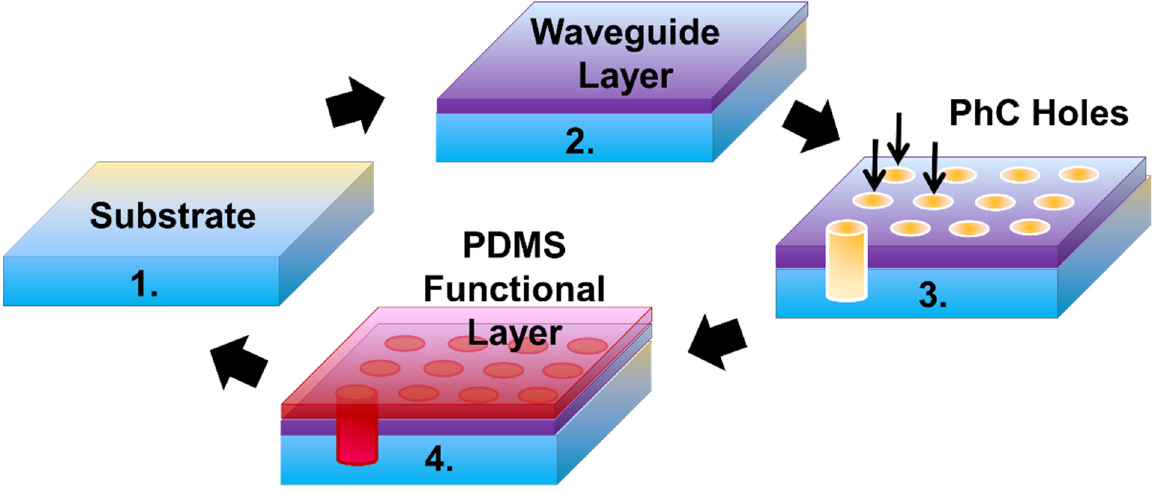
Figure 7. Fabrication steps for implementation of the proposed thermal sensing device.